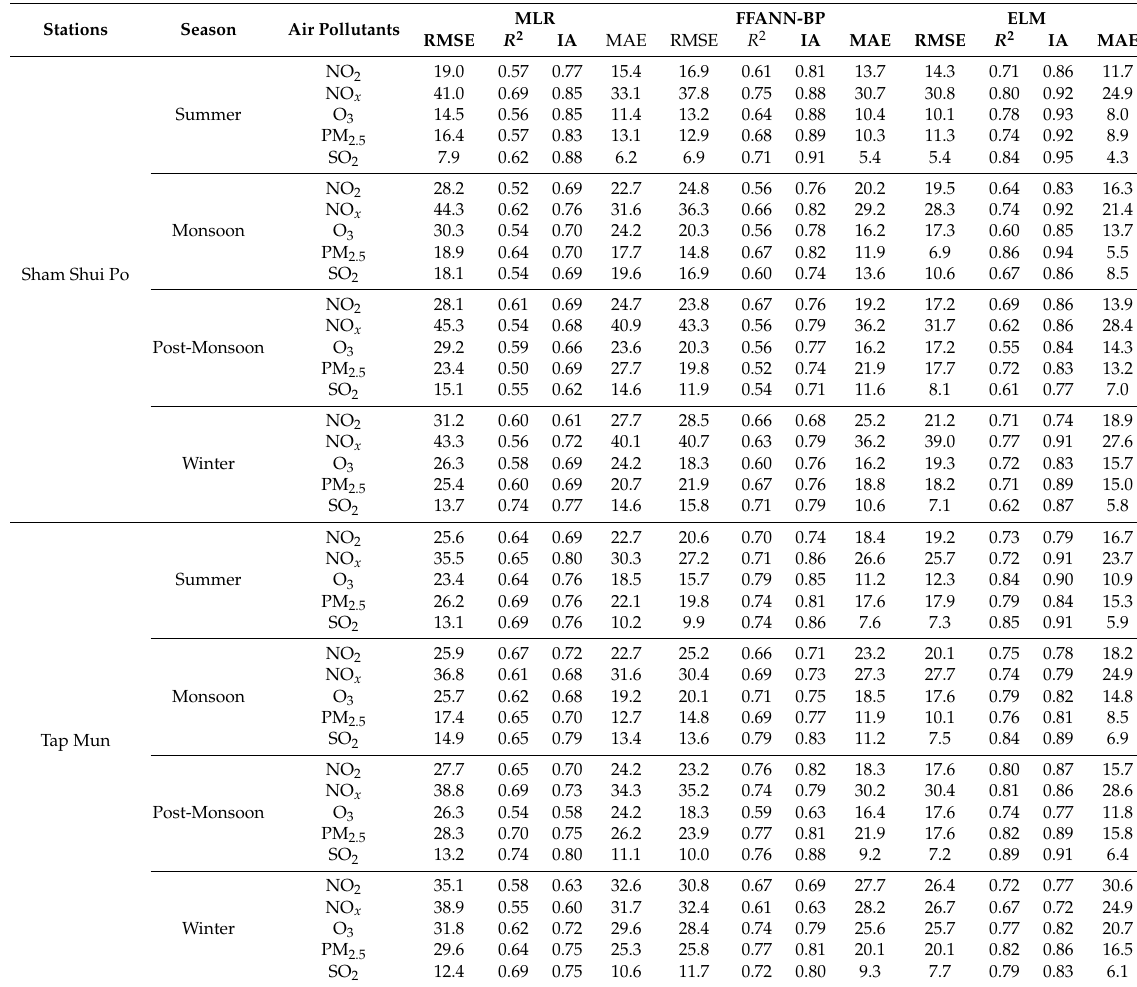
Table 2. The mean performance of multiple linear regression (MLR), feedforward neural network based on back propagation (FFANN-BP), and extreme learning machine (ELM) for Sham Shui Po and Tap Mun. RMSE: root mean square error; R 2 : coefficient of determination; IA: index of agreement; MAE: mean absolute